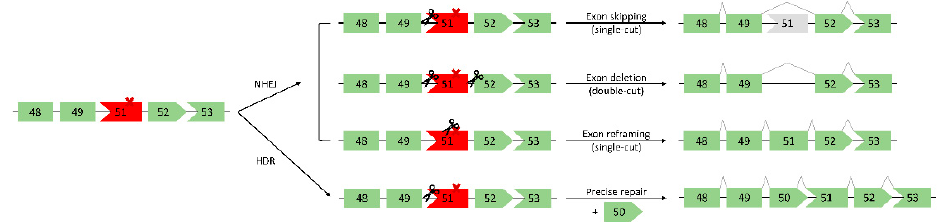
Figure 3. A schematic of DNA repair systems for gene editing with CRISPR/Cas9 in a hypothetical DMD patient harboring an exon 50 deletion mutation. Deleting exon 50 abolishes the reading frame and leads to a premature stop codon in exon 51, denoted by the “X”. Non-homologous end joining (NHEJ) or homology-directed repair (HDR) can restore the dystrophin reading frame. NHEJ exon skipping (single-cut) targets a splice site, thus skipping the adjacent exon. NHEJ exon deletion (double-cut) requires two sgRNAs flanking the out-of-frame exon(s) for removal. Exon reframing (single-cut) relies on indels generated by NHEJ to reframe the out-of-frame exon. Finally, HDR requires an exogenous DNA template to replace the missing or mutated exon in a precise manner. Scissors represent the sites targeted by